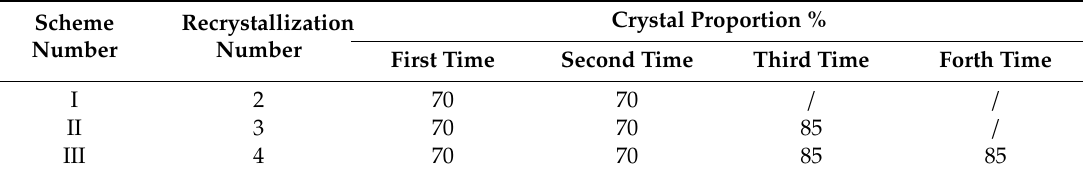
Table 1. Scheme of preparing 6N,7N high-purity gallium by the crystal method.